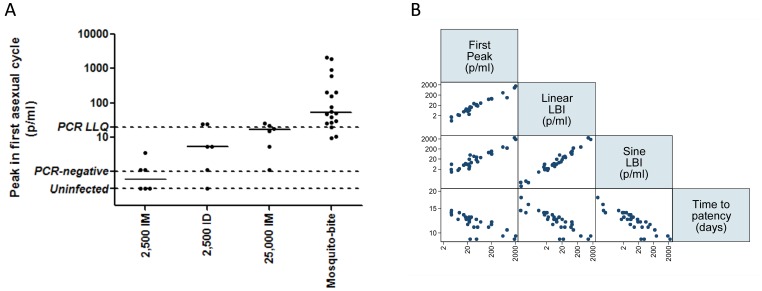
Estimation of Burden of Liver Infection and Liver-to-Blood Inoculum.Data from participants successfully infected with malaria in groups 1, 2 and 3 compared to historical data from mosquito bite CHMI trials undertaken at our centre. SpZ = sporozoites. LLQ = lower limit of quantification by qPCR. ID = intradermal administration. IM = intramuscular administration. Mosquito bite = malaria naïve participants infected with P.falciparum by mosquito bite as infectivity control participants in vaccine efficacy studies undertaken recently at our centre (Ewer et al. submitted). [29] (A) Peak qPCR-measured parasitaemia in first asexual cycle for each regimen. (B) Matrix scatterplot illustrating close correlation of different LBI measures with each other and with time to microscopic patency.